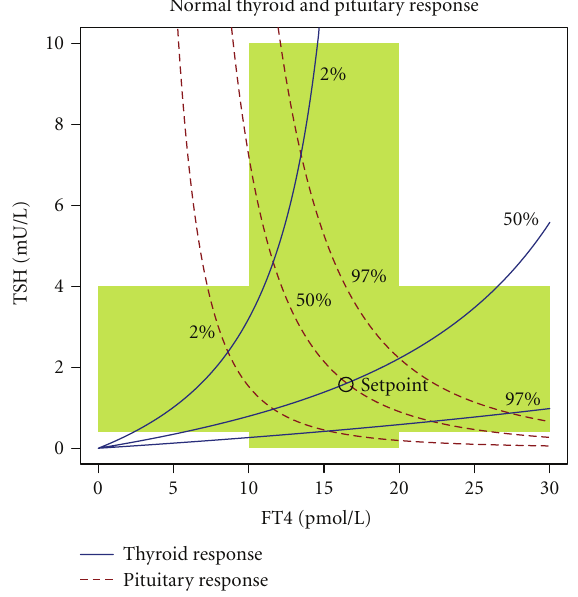
Figure 4: Characteristic curves of pituitary and thyroid. The area shaded in green denotes univariate reference ranges for TSH and FT4. The dashed red line denotes the pituitary’s response in form of TSH incretion to varying FT4 levels; the continuous blue line represents the thyroid’s response to TSH. Note that for the response curve of the thyroid—contrary to convention—the ordinate (TSH) is the independent axis, while the dependent axis is the abscissa (FT4). This uncommon notation facilitates superposition of both characteristic curves. Marked is a normal equilibrium point (also referred to as setpoint) defined by the intersection of both 50% percentiles. Response curves were calculated from percentiles for secretory capacities of pituitary ( G H ) and thyroid ( G T ) using the mathematical model displayed in Figure 2. Structure parameters were derived from a subgroup of subjects included in the NOMO- THETICOS trial